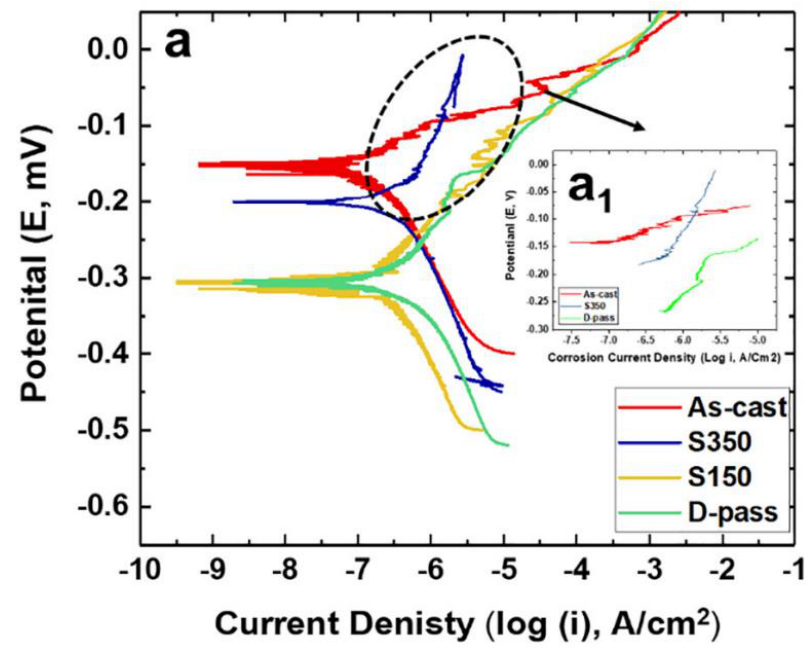
Figure 10. Corrosion behavior of Cu-HEA: (a) Tafel polarization plots for as-cast and as-FSP condi- tions in 3.5 wt% NaCl solution. (a 1 ) Local amplification. [ 73 ] . Copyright 2019 Elsevier.